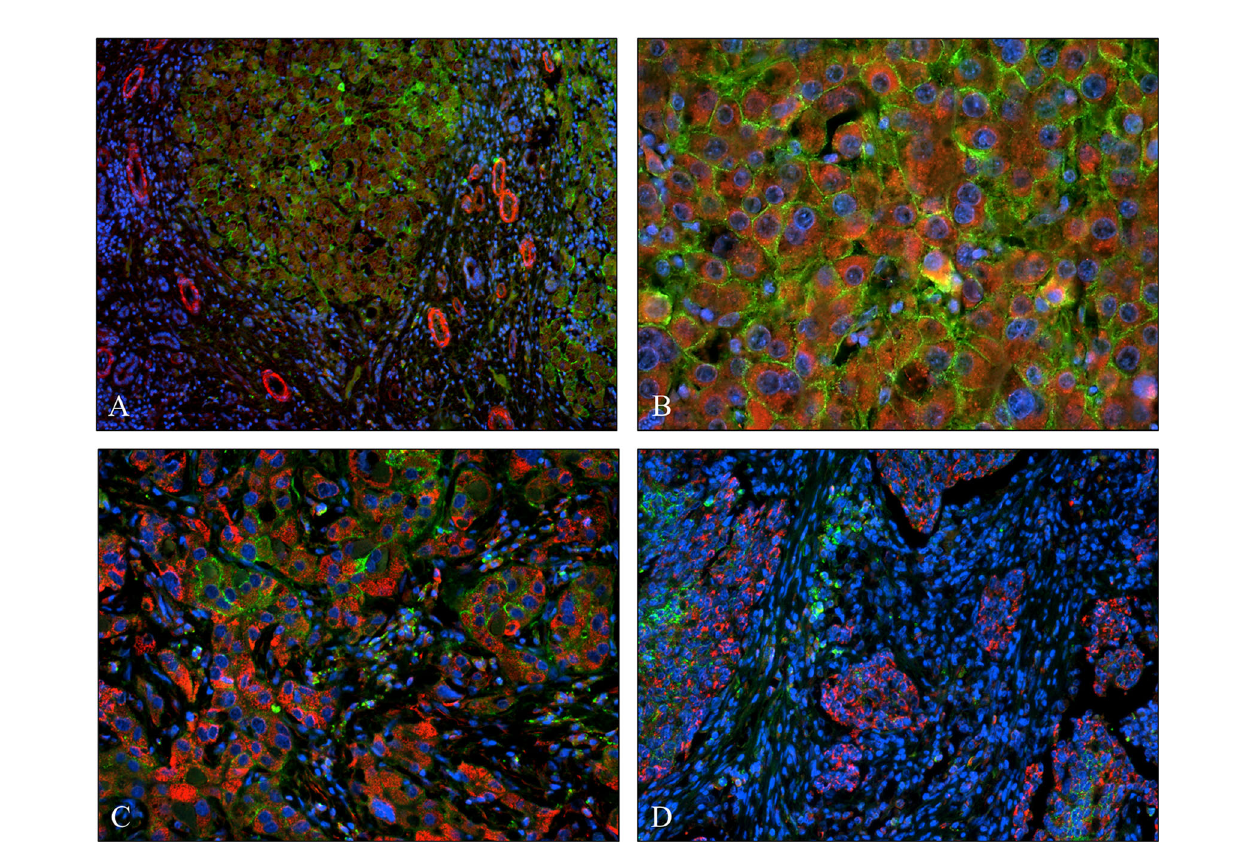
FIGURE 13 | Co-expression of syndecan-1 and SPOCK1 in human liver cirrhosis and hepatocellular cancers. (A) Cirrhotic remodeling of the liver structure. A modest amount of SPOCK1 in the cytoplasm of hepatocytes (red), with syndecan-1 on the surface of the same cells (green). SPOCK1 containing endothelial cells of blood vessels are present in the stroma. (B) Well-differentiated hepatocellular cancer (HCC) with intensive cytoplasmic SPOCK1 staining and large amounts of syndecan-1 on the surface of tumor cells. (C) HCC with de-differentiated cancer cells. Intensive SPOCK1 expression in the cytoplasm; syndecan-1 vanished from the majority of cancer cells. (D) Micro metastases of HCC migrating in the tumor stroma. While SPOCK1 can be detected in large amounts, syndecan-1 protein cannot be